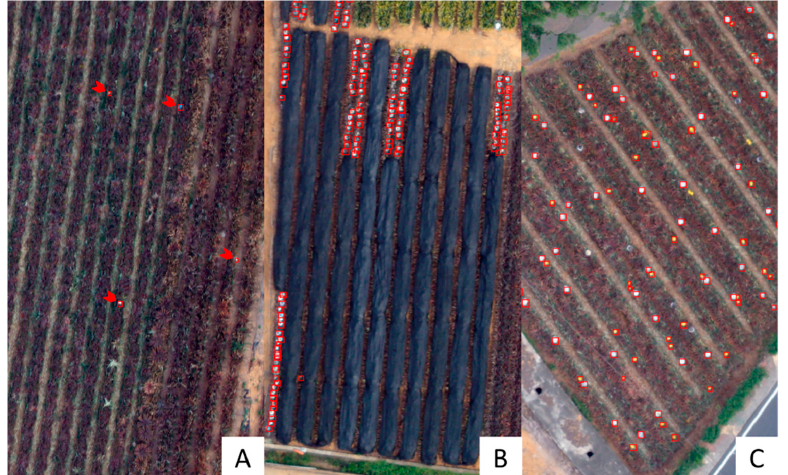
Figure 8. The commission error situations of hat wearer detection. ( A ) Commission error due to similarity of land features; ( B ) mixed use of wearing a hat and covered with nets; ( C ) inconsistency in field maturity, resulting in sporadic hats. The red boxes and red arrows indicated the hat detection results with Faster R-CNN.